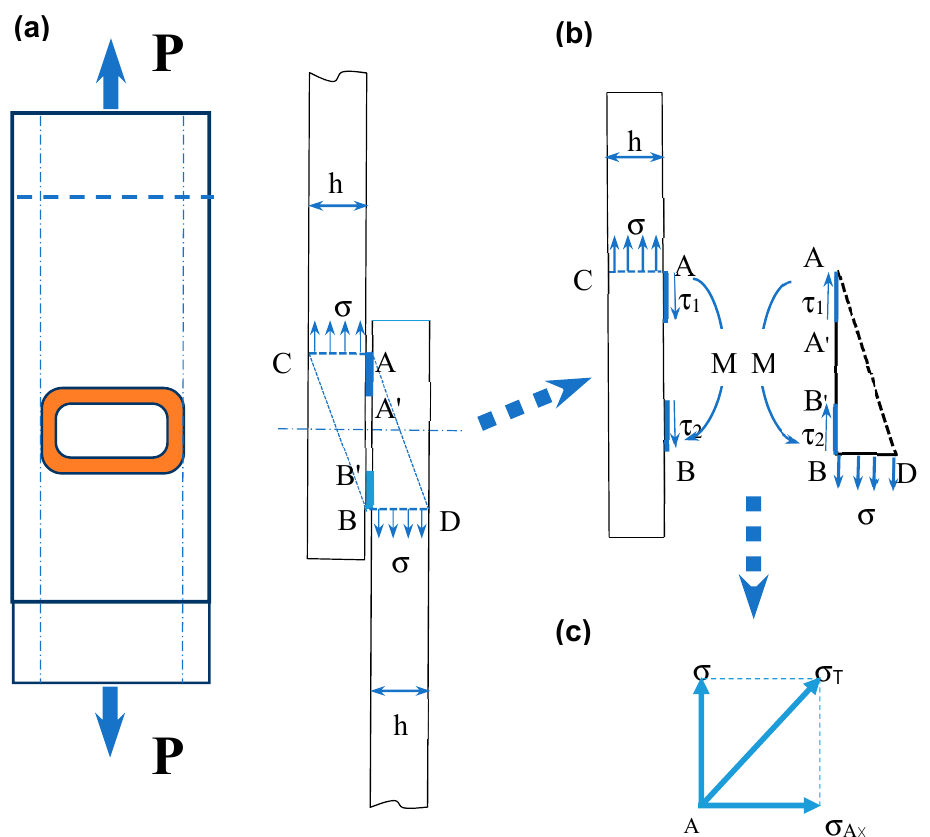
Figure 5. ( a ) Schematic illustration of an EMPWed fatigue (tensile) test specimen, along with ( b , c ) stress analysis in the welding zone.